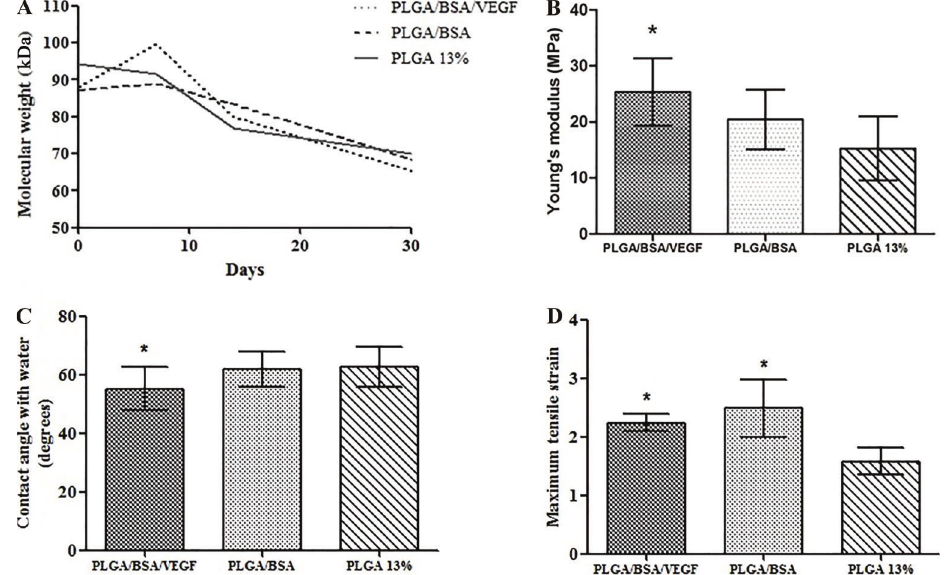
Figure 3. A , Loss of molecular weight evaluated by gel permeation chromatography at different periods: 0 (not submitted to the degradation process), 7, 14, and 30 days (PLGA/BSA/VEGF, PLGA/BSA and 13% PLGA matrixes) (repeated measures with post-hoc Bonferroni). B , Average Young ’ s modulus for the different scaffold groups (one-way ANOVA with post-hoc Tukey ’ s test). C , Contact angle in the PLGA/BSA/VEGF, PLGA/BSA and 13% PLGA fi lms with average values of 55.22 ± 3.22°; 61.72 ± 4.3° and 62.73 ± 4.66°, respectively (repeated measures with post-hoc Bonferroni). D , Maximum tensile strain for the different scaffold groups (one-way ANOVA with post-hoc Tukey ’ s test). Data are reported as means ± SD. *P o 0.05 compared to 13% PLGA. PLGA: polylactic-co-glycolic acid; BSA: bovine serum albumin; VEGF: vascular endothelial growth factor.